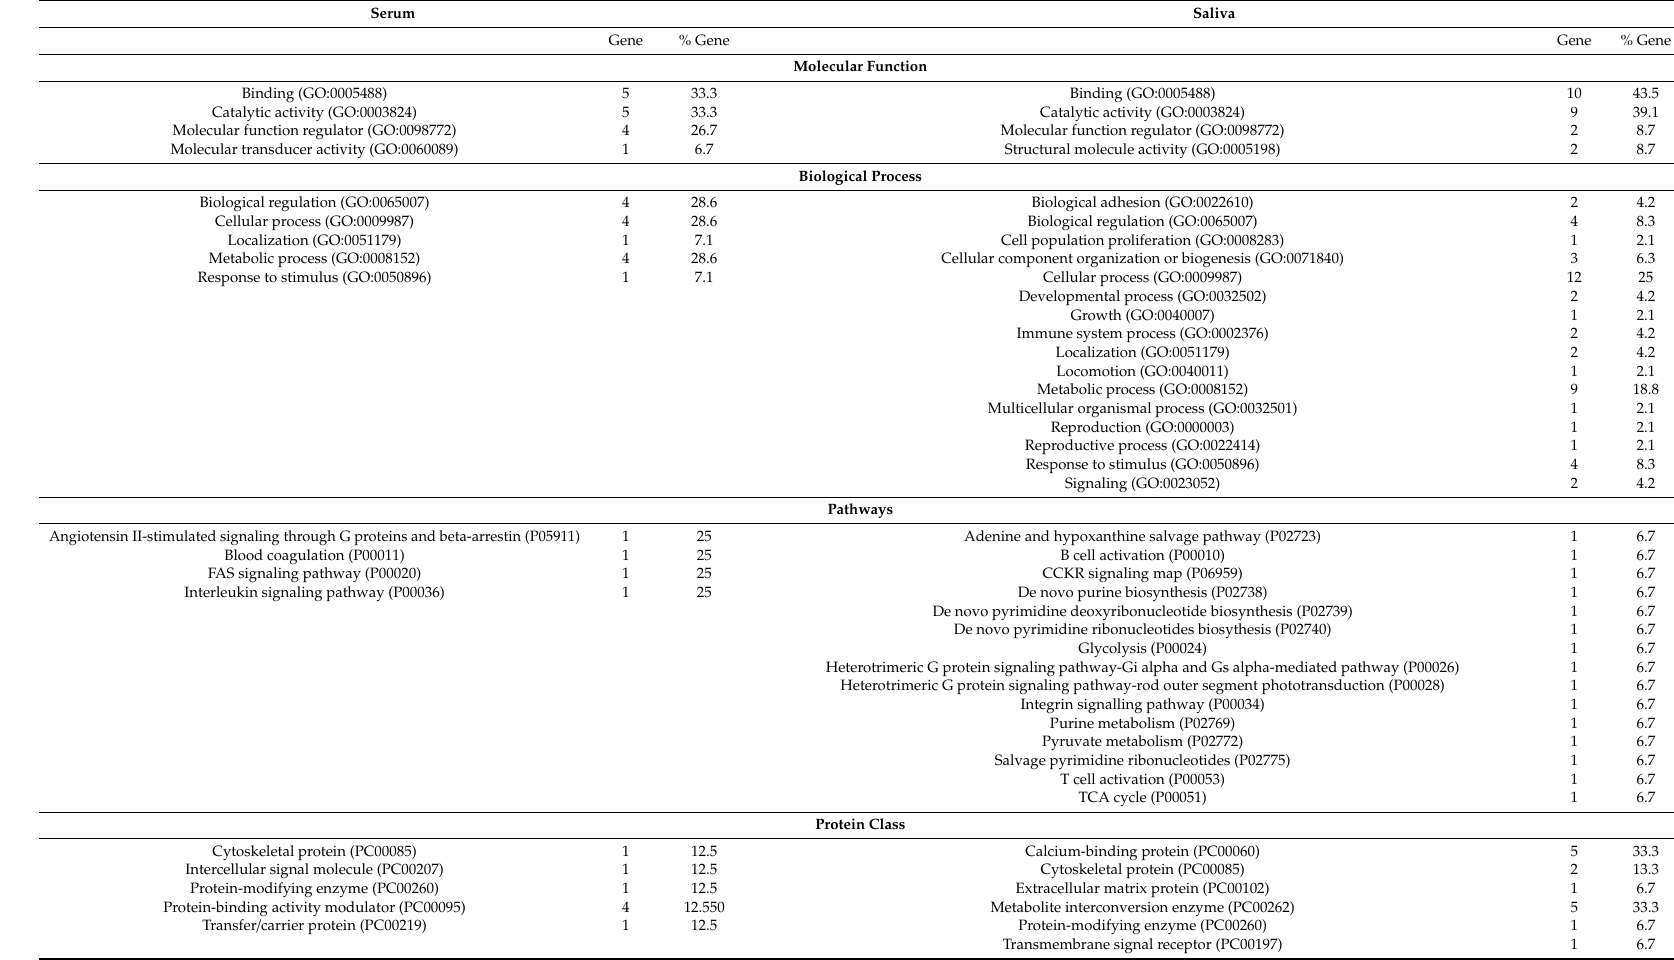
Table 2. Molecular function, biological process, pathways, and protein class as the number of genes and gene percentage of the di ff erentially expressed proteins in the HC and CMT groups in serum and saliva based on the Protein Analysis Through Evolutionary Relationships (PANTHER) classification